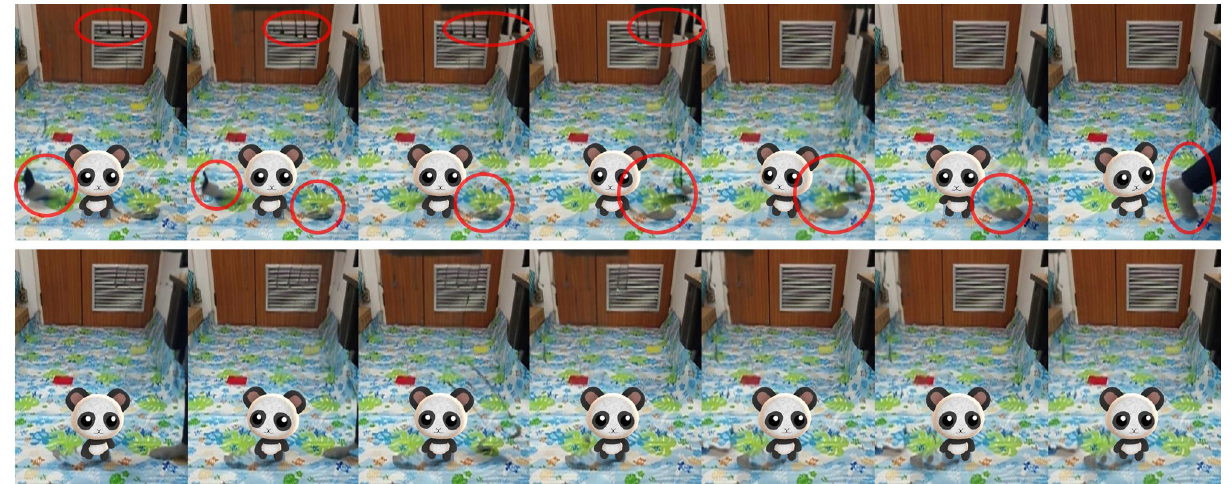
Figure 5. Photographs of visual artifacts from the inpaint condition. These snapshots capture a pedestrian walking every 0.3 s. The first row (with red circles) and second row are the sequences of walking from left to right and from right to left,